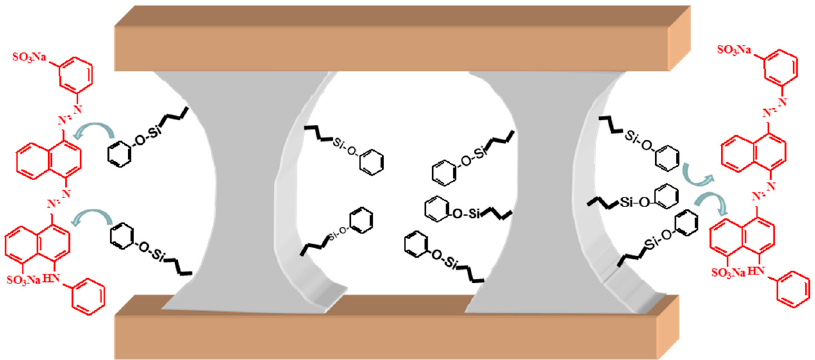
Figure 4. Proposed mechanism of interaction between Φ 5 -PPH and AB113.